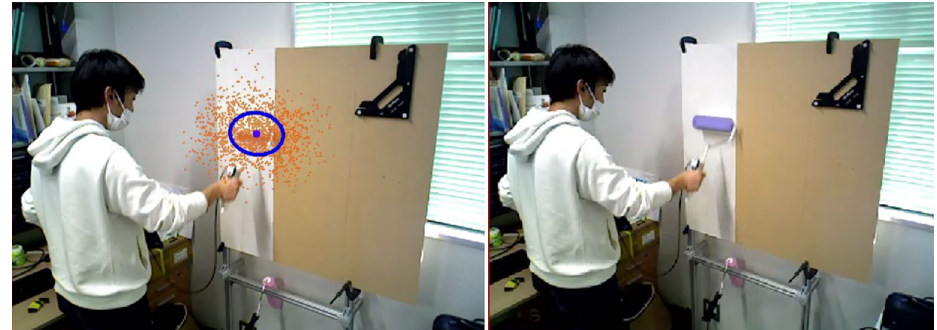
Fig. 11 Particles and ellipses (left); Estimated pose (right)